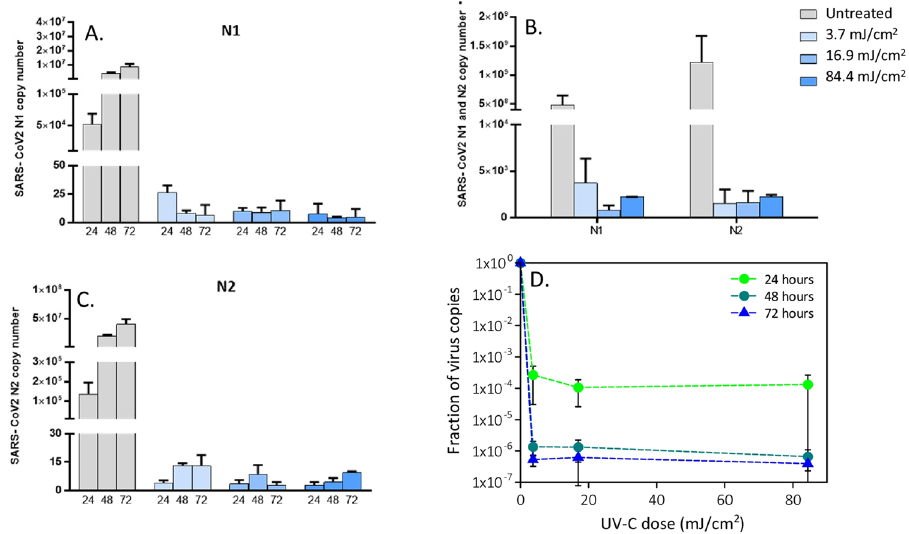
Figure 2. Viral replication of UV-irradiated SARS-CoV-2 (5 MOI) virus in in vitro VeroE6 cells. Vero E6 cells were infected with UV-C irradiated SARS-CoV-2 virus at a MOI of 5. Culture supernatants were harvested at the indicated times (24, 48 and 72 h) and virus titers were measured by absolute copy number quantification (Real-Time PCR, A , B ). Viral replication was assessed even on cell lysate harvested at the end of cell cultures (72 h) ( C ). All cell culture conditions were seeded in duplicate. Panel ( D ) reports the plots of the measured virus copies normalized at the untreated sample in the different conditions. For descriptive purposes, mean values and whiskers representing the observed half-ranges are shown.